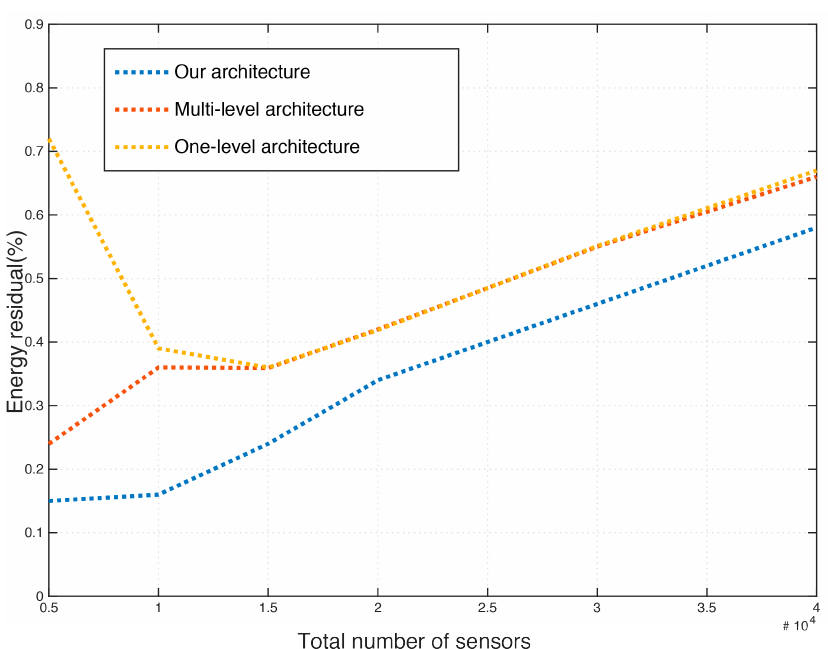
Figure 14. Average residual energy rate according to